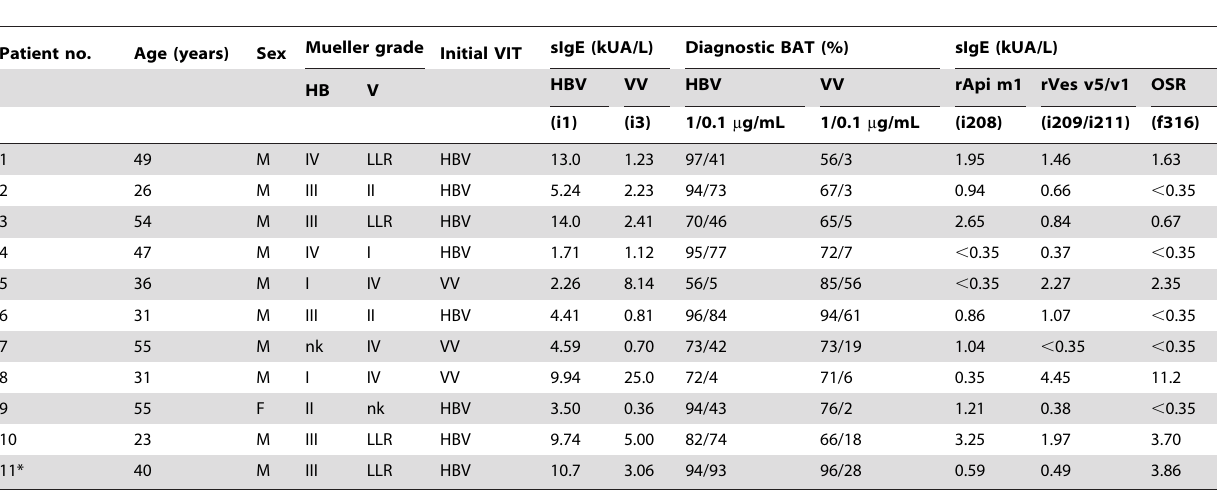
Table 1. Clinical data, sIgE and BAT in double positive subjects.